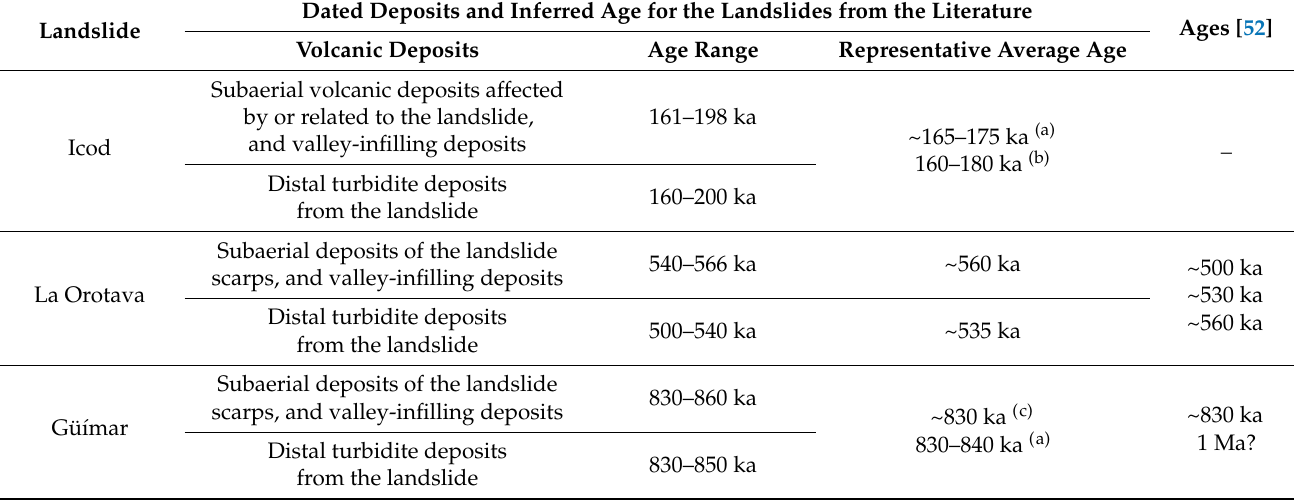
Table 2. Age of the most recent (last million years) landslides in Tenerife ([52] and references therein). Dated Deposits and Inferred Age for the Landslides from the Landslide